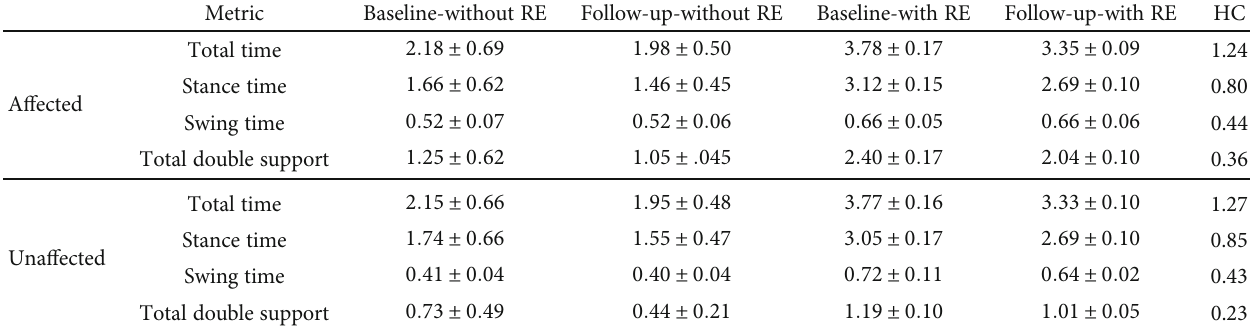
Table 4: Mean ± standard error of temporal